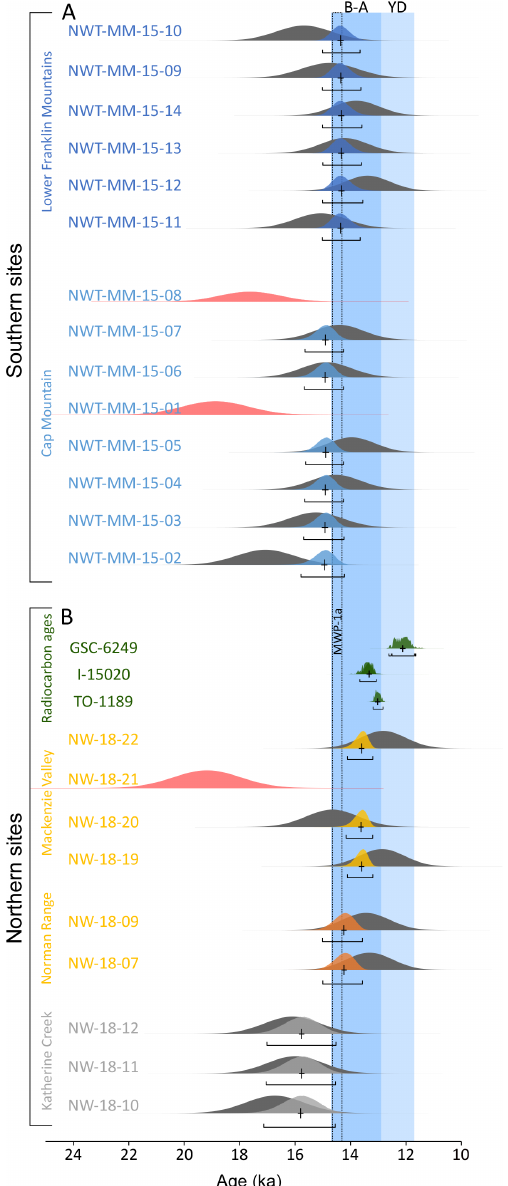
Figure 6. (a) Phase model from the Bayesian modelling showing the exposure age probability for the southern sites. The dark grey probability distribution plots relate to the age distribution of individ- ual TCN exposure ages. The coloured plots indicate the modelled age probability distribution from our Bayesian modelling. Black crosses indicate the median modelled age, with uncertainty. The red plots indicate ages which were identified as outliers within the model. Full information on the Bayesian modelling is provided in Figs. S3 and S4 and Tables S4 and S5. Shaded blue areas indicate the timing of the Bølling–Allerød interval (B–A) and the Younger Dryas interval (YD). (b) Phase model from the Bayesian modelling showing the exposure age probability for the northern sites. The red plots indicate ages which were identified as outliers within the model. The probability distribution of the three oldest radiocarbon ages which constrain our model is displayed in dark